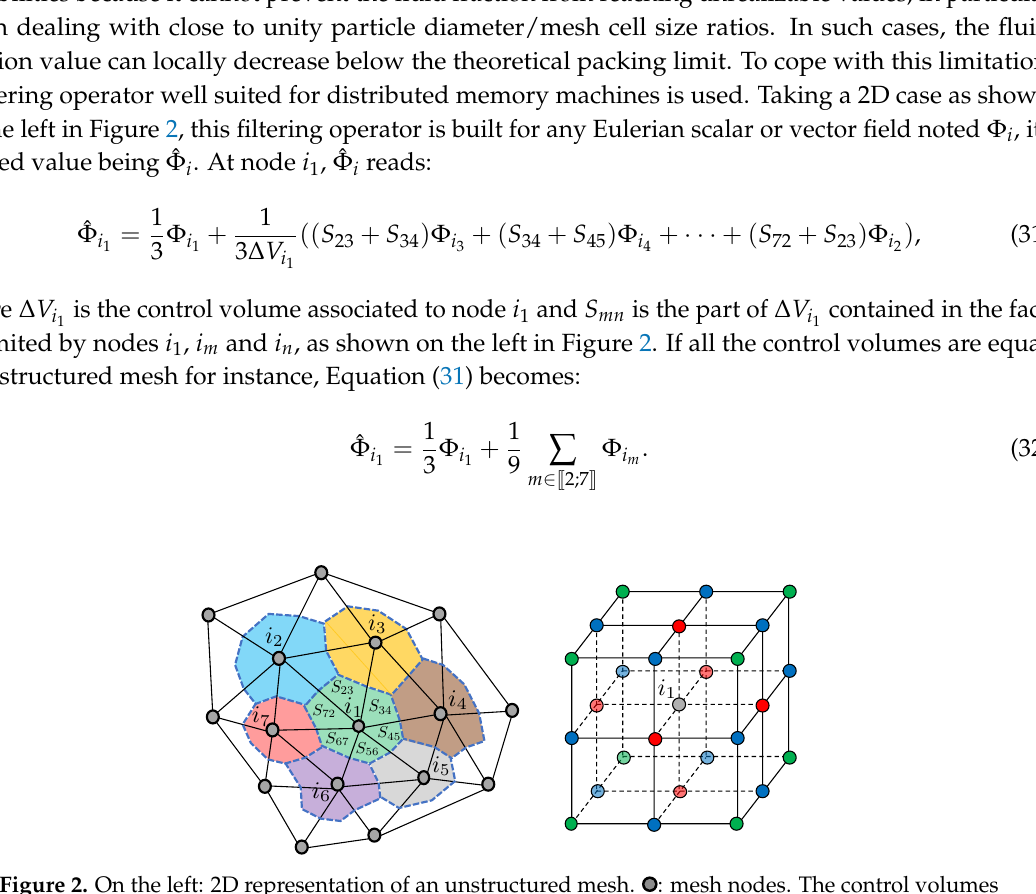
Figure 2. On the left: 2D representation of an unstructured mesh. : mesh nodes. The control volumes of nodes i 1 ( ), i 2 ( ), i 3 ( ), i 4 ( ), i 5 ( ), i 6 ( ), i 7 ( ) are shown. The control volume of node i 1 is composed of surfaces S 23 , S 34 , S 45 , S 56 , S 67 and S 72 . On the right: 3D representation of a regular Cartesian mesh part. : node i 1 . : nodes at faces’ center. : nodes at edges’ center. : nodes at